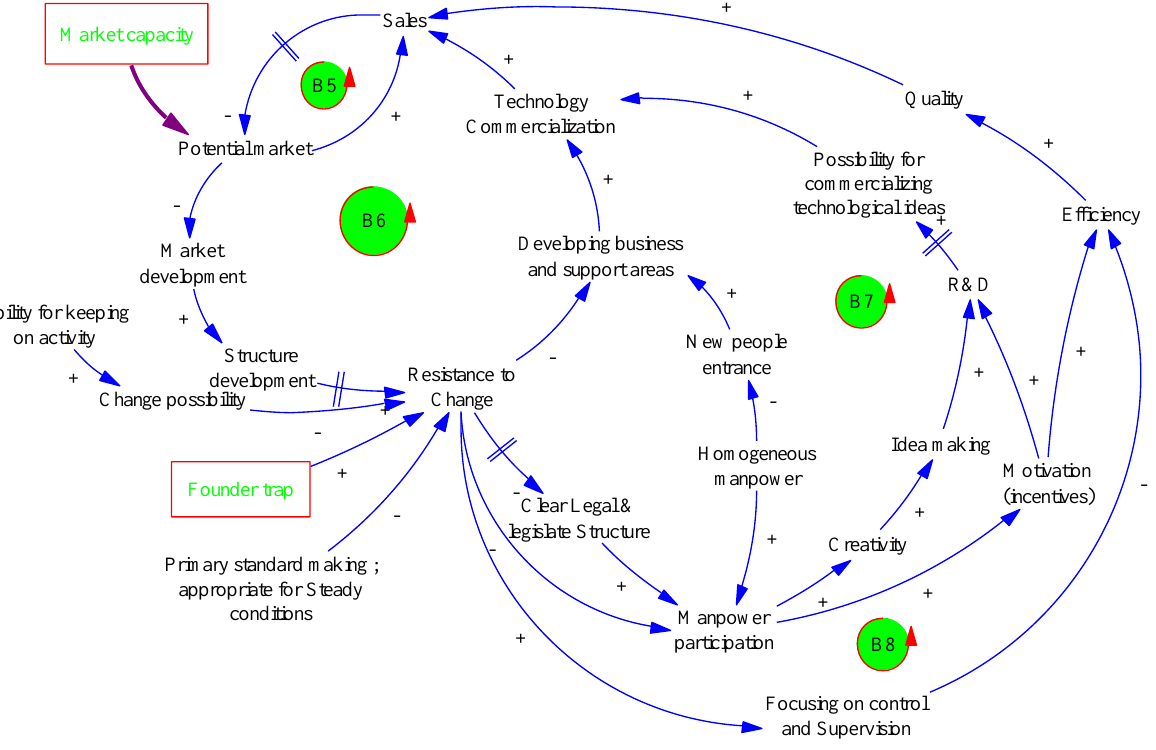
Figure 8. Market development loop and